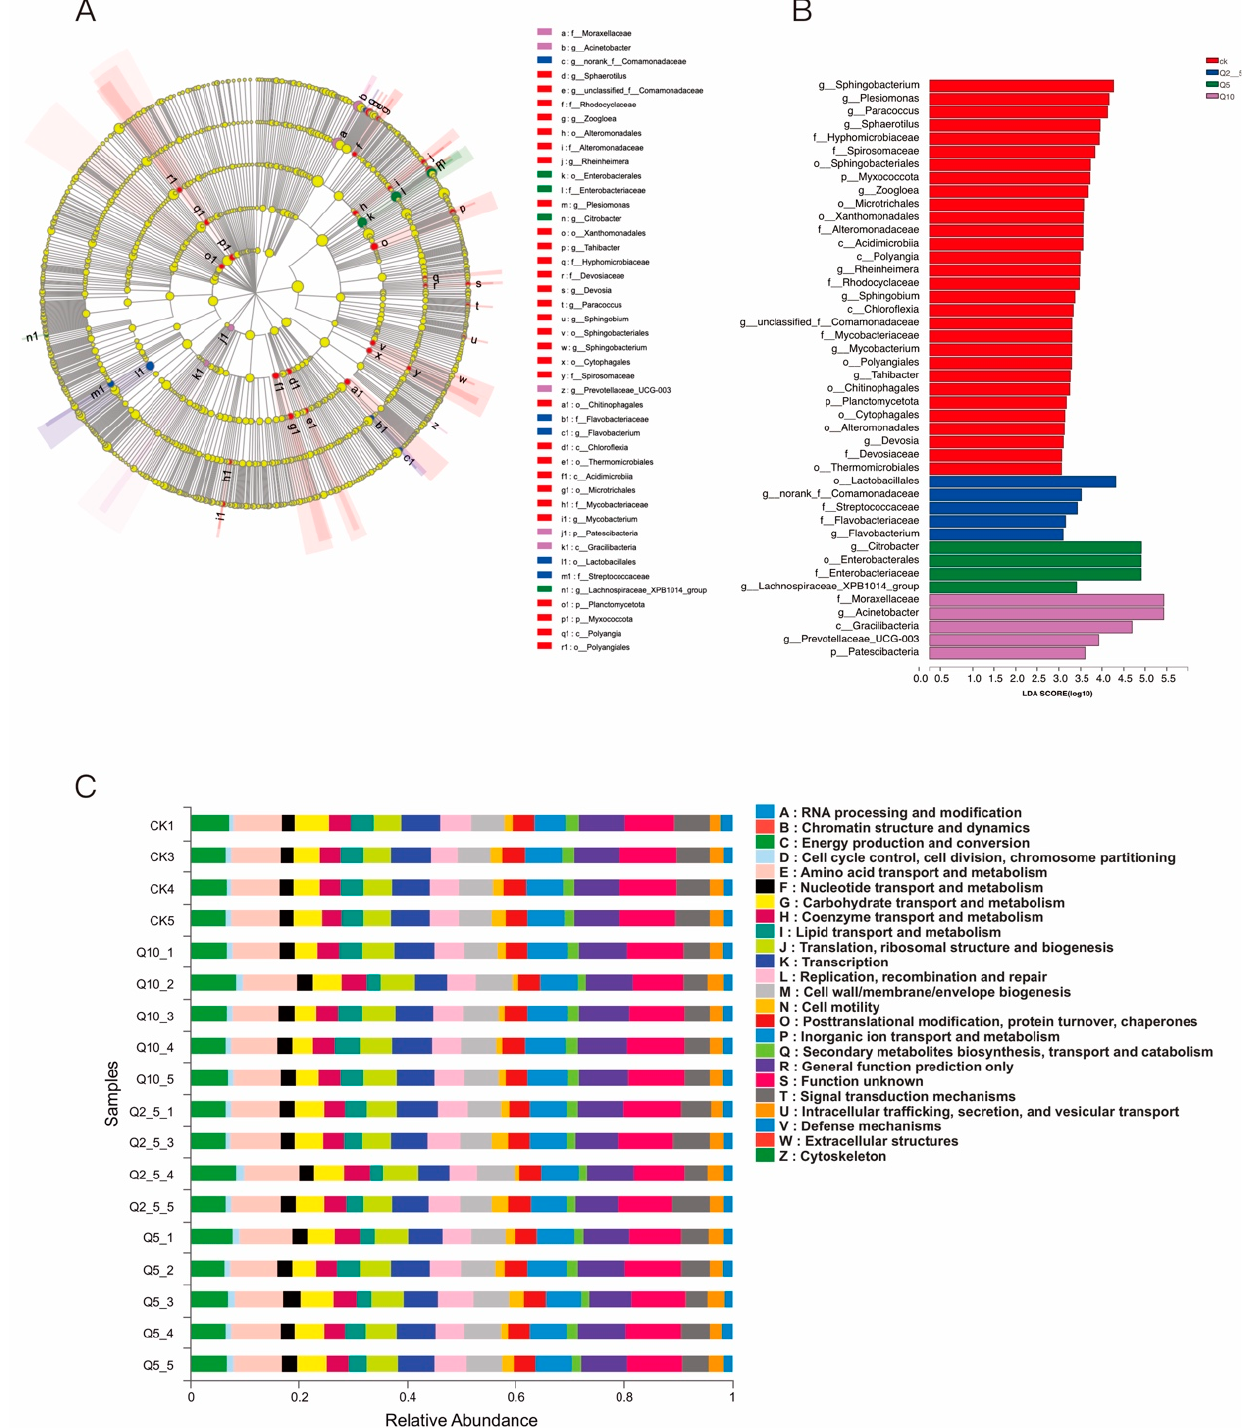
Figure 6. Regulation of bacterial metabolic pathways by quercetin. ( A ) LDA analysis; ( B ) LEfSe analysis; and ( C ) analysis of the KEGG metabolic pathway differences among the